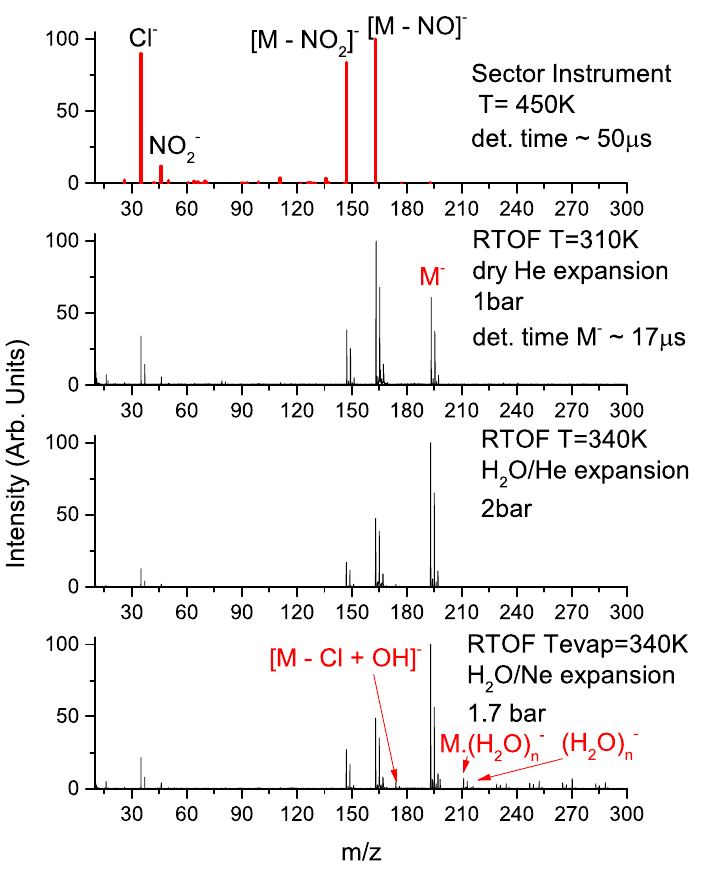
Figure 2. Mass spectra of negative ions formed by C 4 HCl 2 N 3 O 2 interaction with electrons in the range of 0–14 eV. Top bar graph spectrum is for isolated molecule, obtained as an integral of the individual ion yields measured at the electron attachment spectrometer with sector mass analyzer in Ufa. Below are the spectra from RTOF measurements with molecular beam of C 4 HCl 2 N 3 O 2 in He, hydrated He and hydrated Ne as a buffer gas—increasing hydration from top to